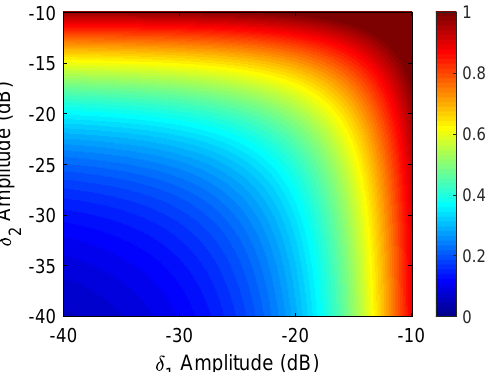
Figure 3. The estimation error of the ICT calibration scheme for the transmission axial ratio under different crosstalk